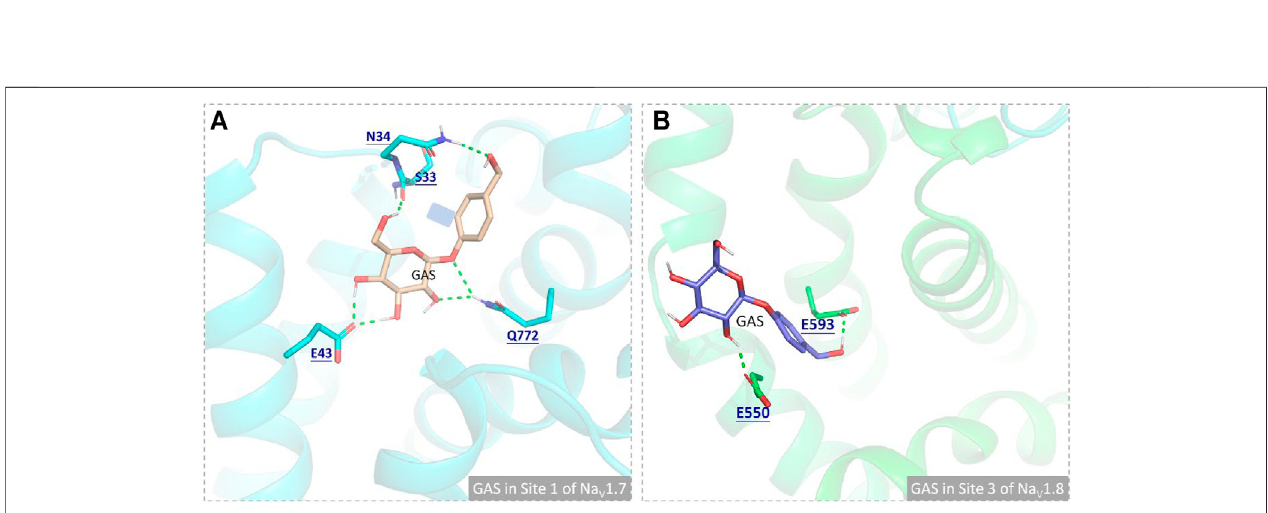
FIGURE 9 | Comparison of the binding interactions of GAS on the active pockets of Na V 1.7 and Na V 1.8, and the hydrogen bonds were shown in green dashed lines: (A) GAS in Site 1 of Na V 1.7; (B) GAS in Site 3 of Na V 1.8.